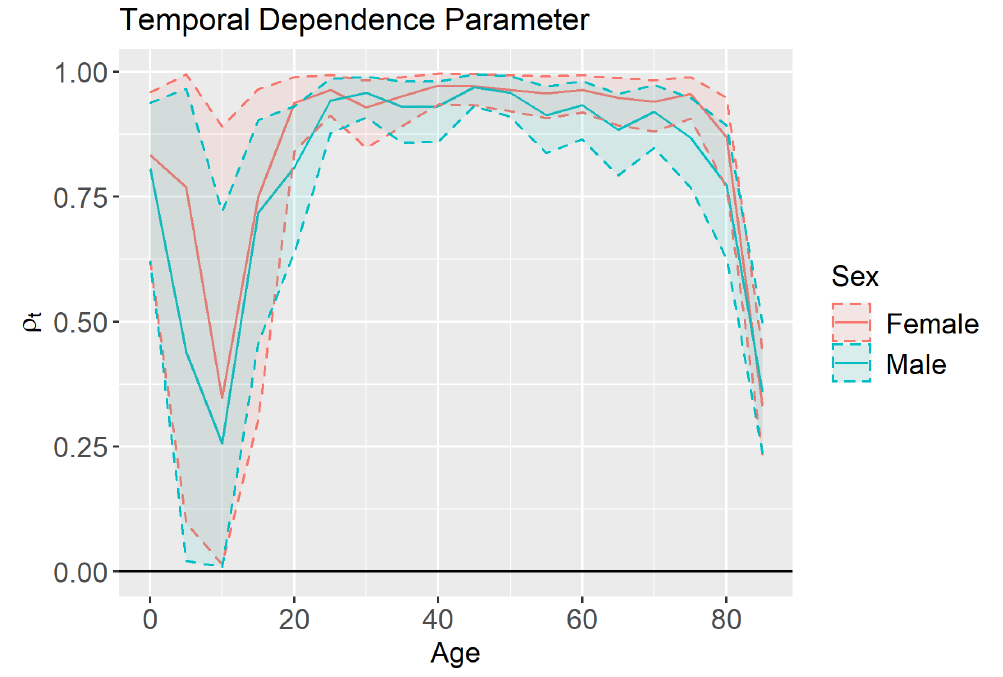
Figure 10. Temporal dependence parameter ( ρ t ) estimates and 95% credible intervals by age and sex.